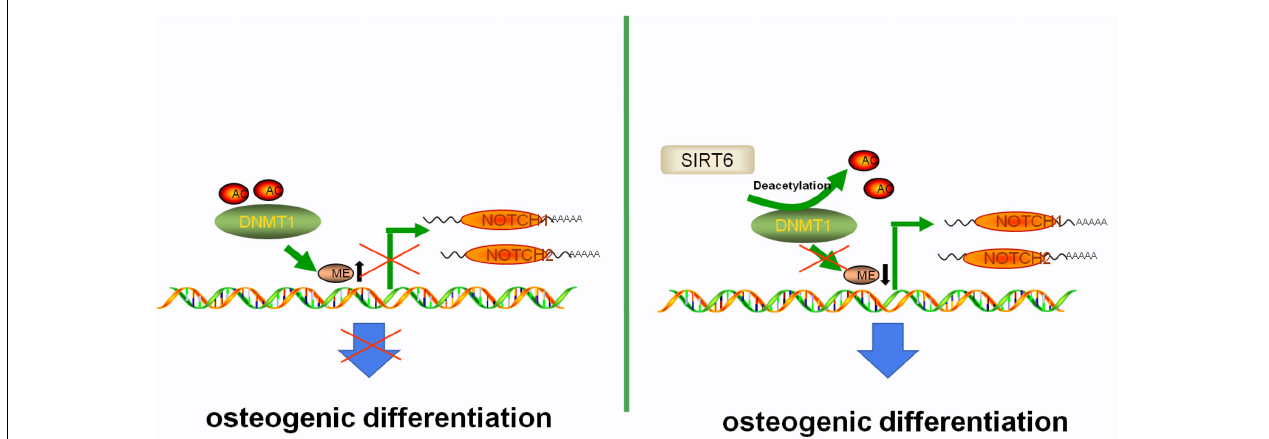
FIGURE 7 | The proposed mechanism of SIRT6-induced osteogenic differentiation of adipose-derived mesenchymal stem cells. SIRT6 tightly regulates the level of NOTCHs by antagonizing the DNMT1 protein at the level of protein stability. Abnormal DNA methylation status of NOTCHs caused by DNMT1 in SIRT6 deficiency impairs the osteogenic differentiation potential of ADSCs. In the present of SIRT6, the histone acetylation status of the DNMT1 was upregulated, leading to the increased expression of NOTCH1 and NOTCH2, which further promotes the osteogenic differentiation capability of ADSCs.